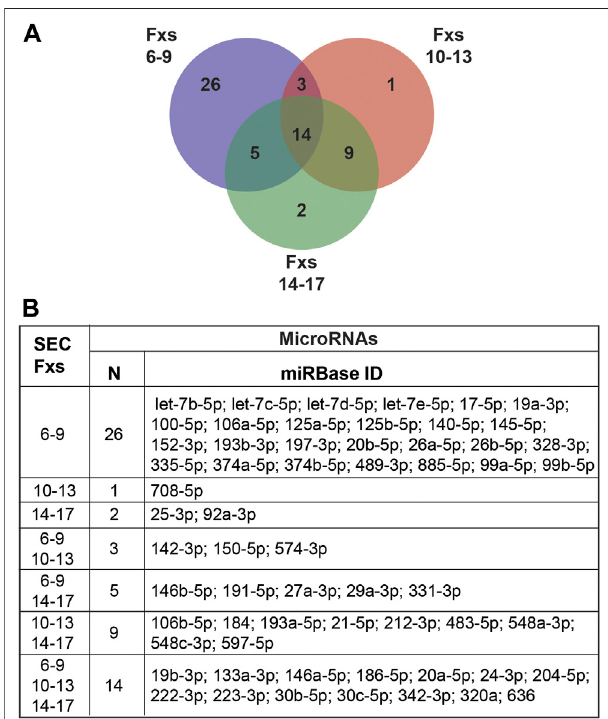
FIGURE 6 | MiRNA expression in pooled CSF SEC fractions. CSF from CTLs (n = 4) was fractionated by SEC, then combined into three pools (Fxs 6 – 9, 10 – 13, and 14 – 17) and assayed for miRNA expression. (A) Venn diagram ofthe number of miRNAs expressed in each individual pool and thoseincommonbetweentheSECpools. (B) TablelistingthemiRNAsunique to orshared between thepools. Inclusion criteria for miRNAs wereexpression in at least two of the four participant